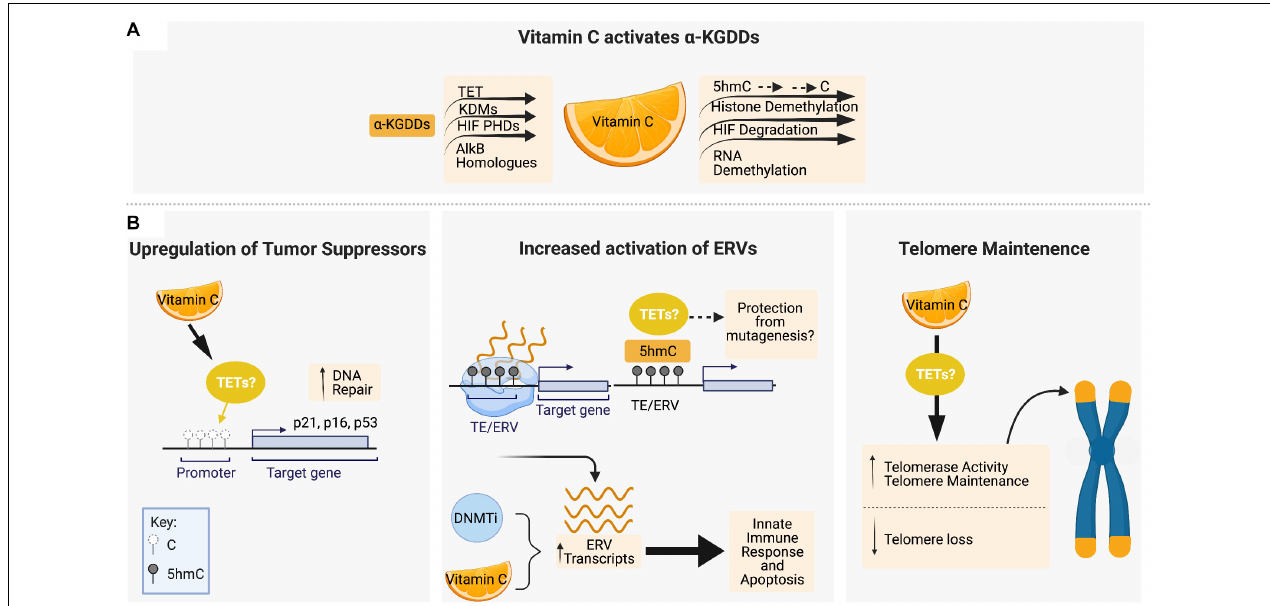
FIGURE 2 | Vitamin C maintains genomic stability through interactions with epigenetic regulators, tumor suppressor upregulation and telomere maintenance. (A) Vitamin C serves as a cofactor for members of the α -ketoglutarate-dependent dioxygenases ( α -KGDD) family such as TETs, KDMs, HIF PHDs, and ALKBHs, which can work to maintain genomic stability through the demethylation of 5mC residues, histone demethylation, HIF-1 α degradation, and RNA demethylation, respectively. (B) Vitamin C supplementation has been shown to promote DNA demethylation in the promotor regions of tumor suppressor loci encoding p16, p21, and p53. Vitamin C promotes DNA demethylation and 5hmC formation at transposable elements (TEs) in the genome, leading to upregulated expression of endogenous retroviral genes (ERVs) in combination with DNA methyltransferase inhibitors (DNMTis). In cancer cells, ERV upregulation initiates an innate immune response and apoptotic cell death which is enhanced by vitamin C. Vitamin C treatment has also been shown to increase telomerase activity and the expression of genes that protect telomere integrity and decrease the rate of telomere loss. Figure created with